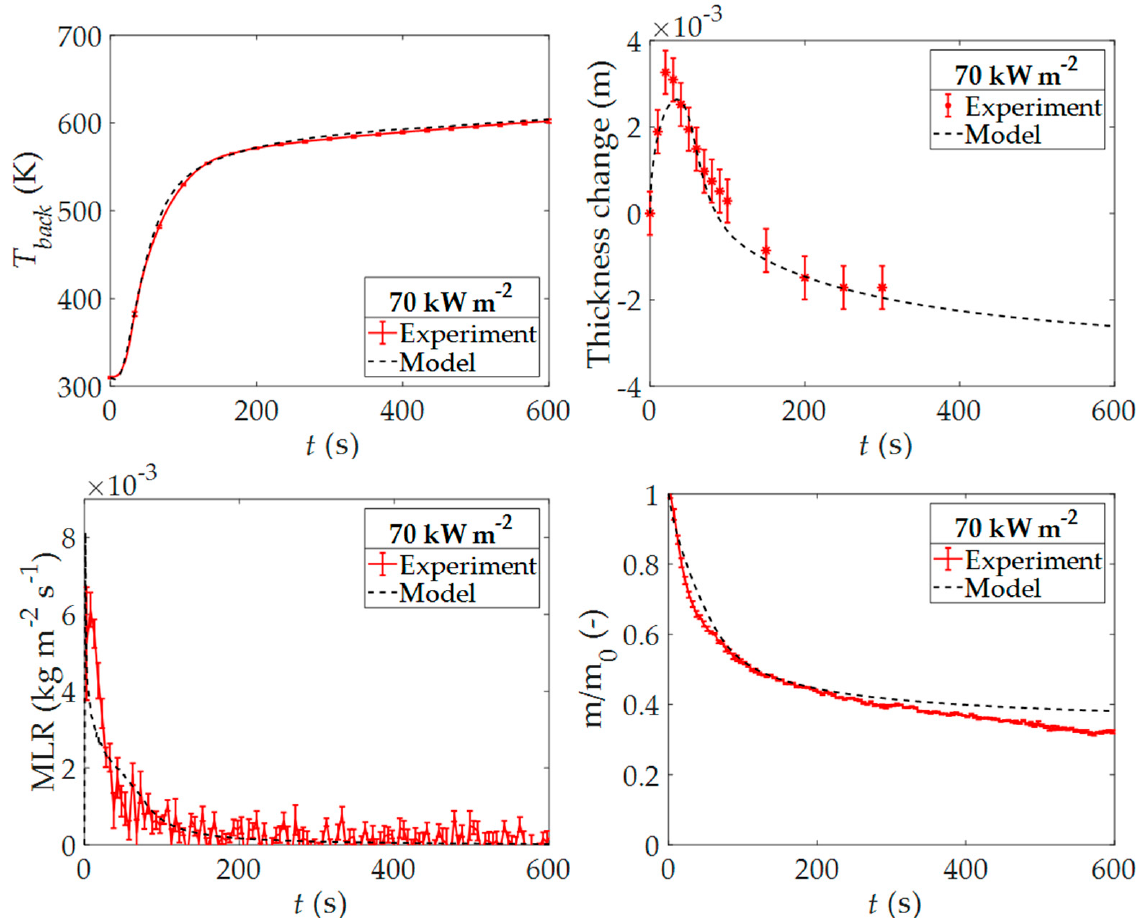
Figure 5. Mean experimental results and model predictions for the Controlled Atmosphere Pyrolysis Apparatus II (CAPA II) tests performed on the PIR foam at 70 kW m − 2 of set radiant heat flux.